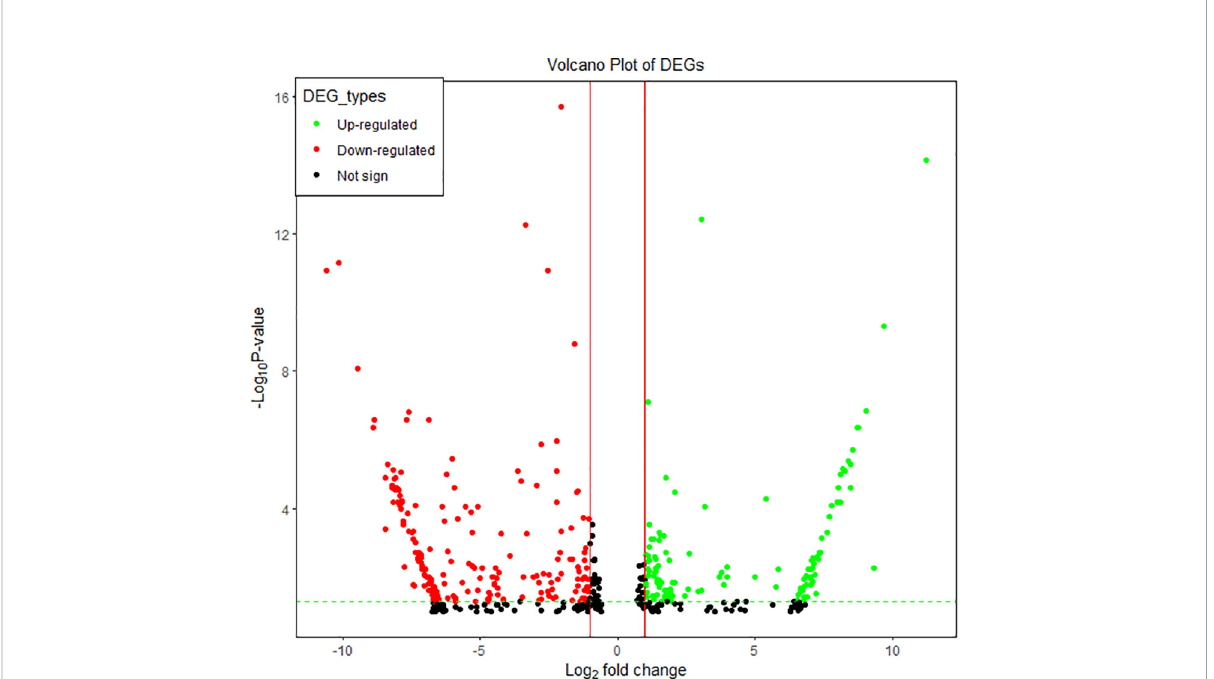
FIGURE 7 Volcano plots of signi fi cantly differentially expressed genes between the two groups of fi nger millet genotypes. Each dot represents a gene. Dots in green represent genes that were up-regulated in the Al-tolerant group, dots in red represent genes that were down-regulated in the Al- tolerant group, and dots in black represent genes that were not signi fi cantly differentially expressed (Not sig).